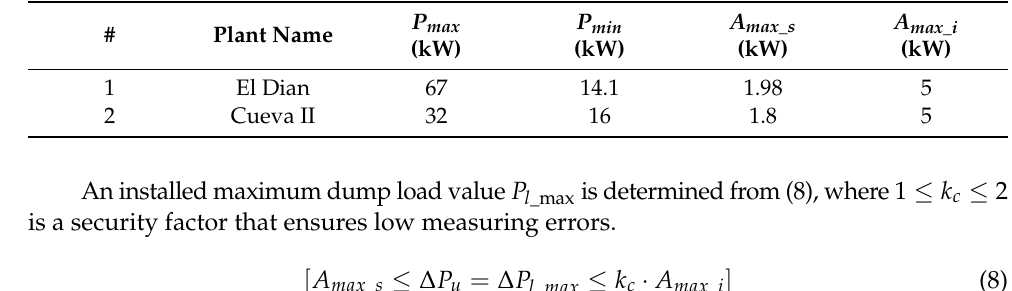
Table 4. Measures of typical users load demand.